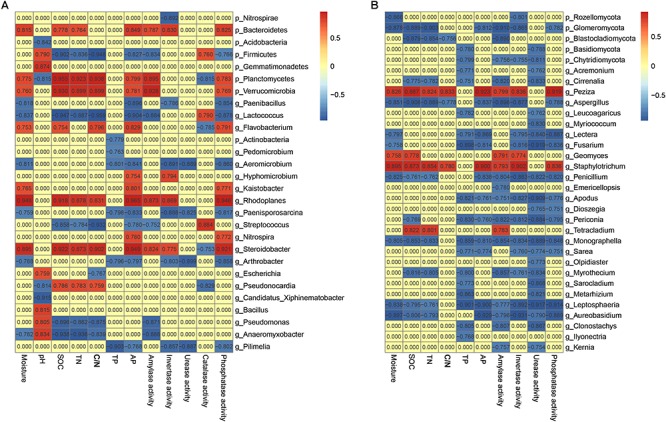
Heatmaps showing bacterial (A) and fungal (B) co-occurrence in soils. Top 10 bacterial phyla, top 7 fungal phyla as well as top 35 genera were displayed. A connection stands for SRCC with a magnitude >0.75 or < –0.75 and statistically significant (P < 0.05).